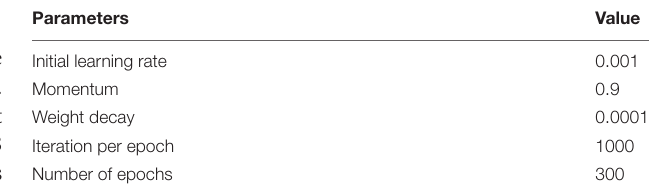
TABLE 1 | Training parameters of multi-modal weeds detection